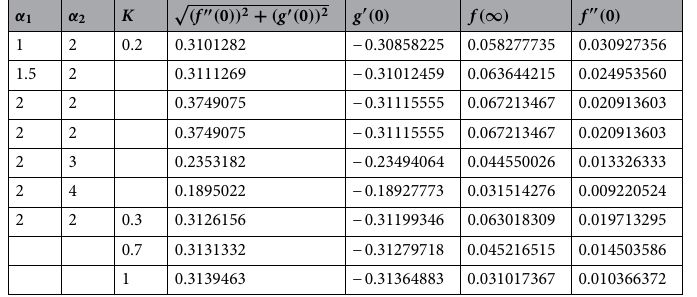
1 / 2 x against the various values of α 1